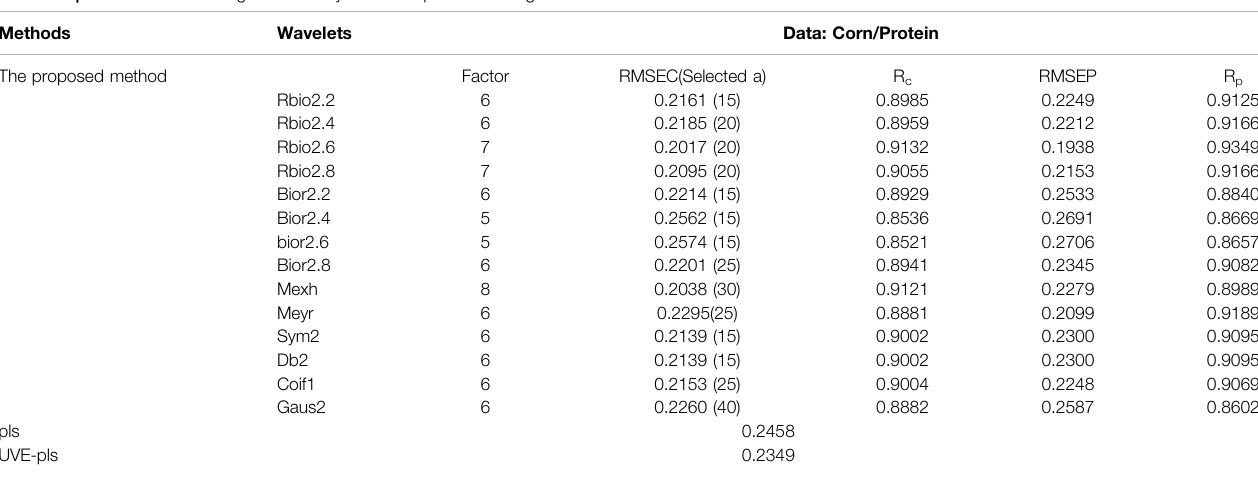
TABLE 1 | The results of the regression analysis for the protein NIR signal.